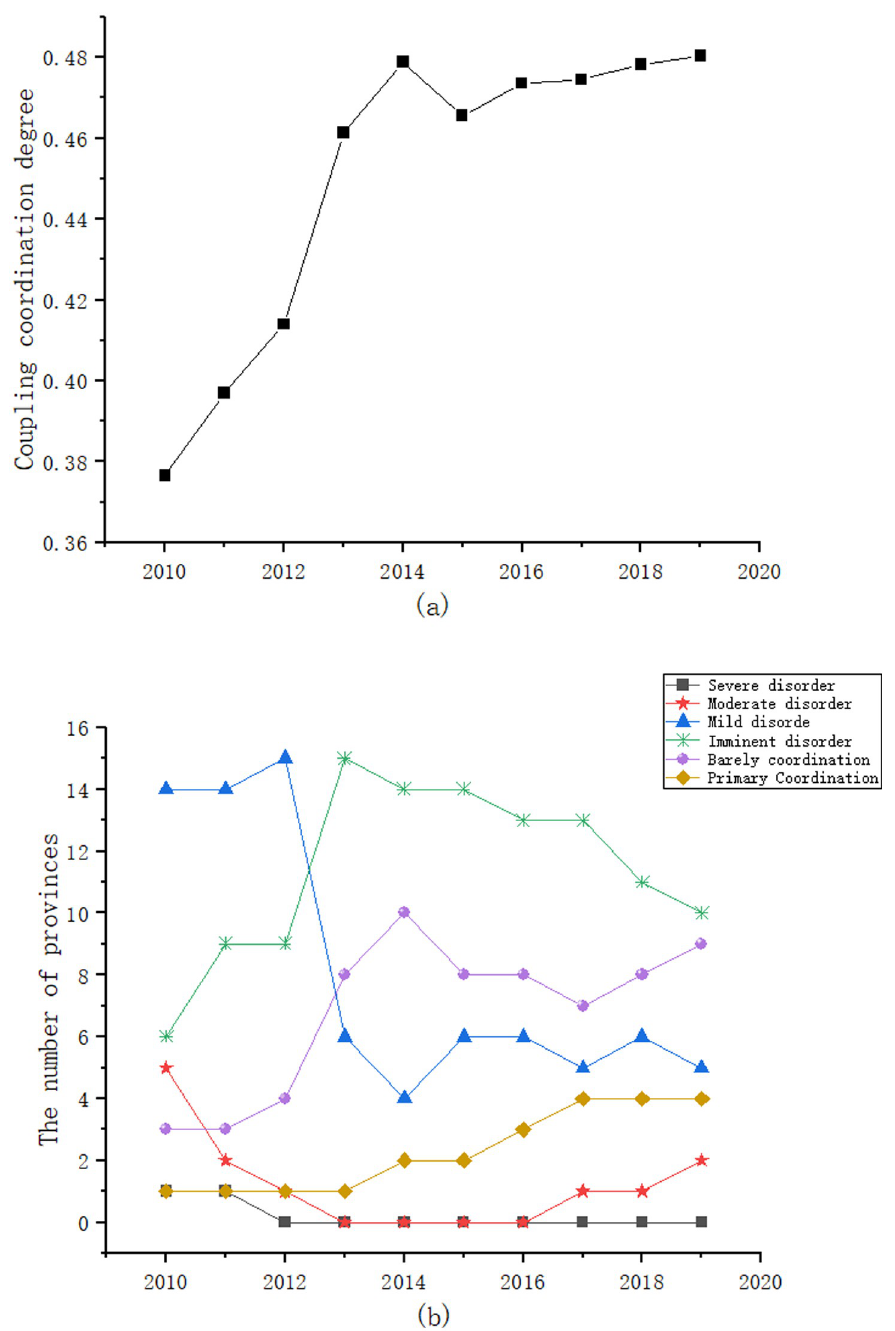
Fig 3. Trends in the coupling coordination development of the energy-economy-carbon emission system in